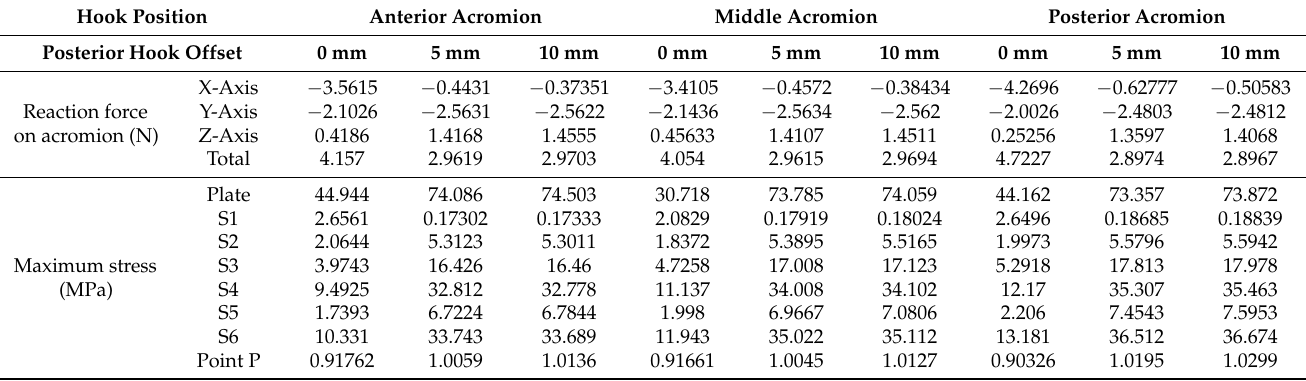
Figure 8. The reaction force on the acromion. Table 3. The reaction force on the acromion and the stress on the clavicle hook plate, each screw, and at point P of the clavicle.